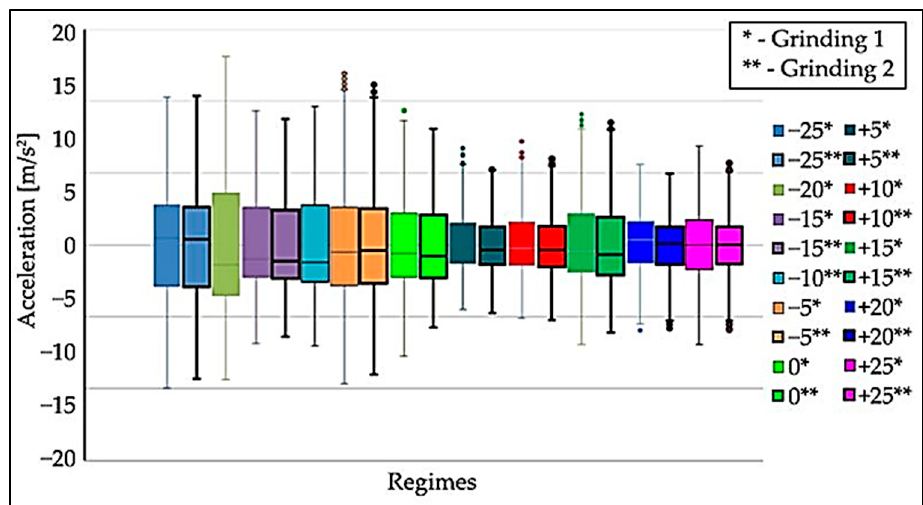
Figure 12. Boxplots of the acceleration of the oscillation in the tested modes on the ruler in the “ z -axis” direction, grinding wheel speed—1907.2 [rpm], basic speed (regime 0) for regulating wheel—